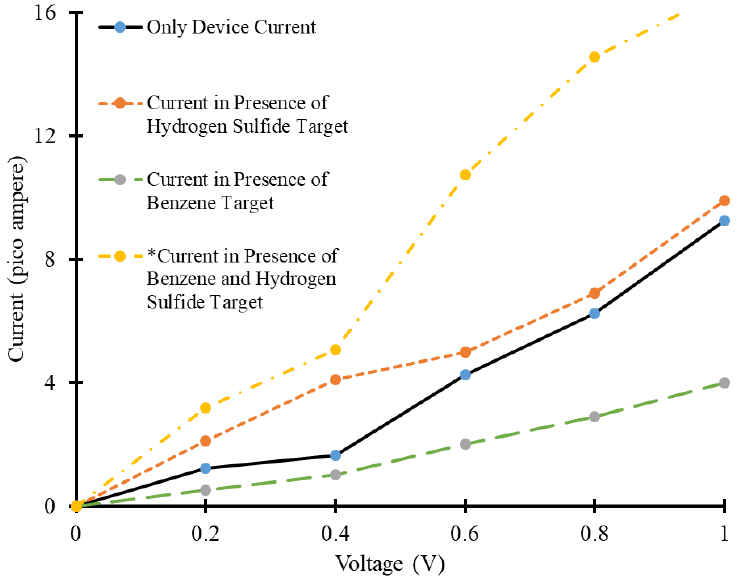
Figure 4. Current-voltage ( I - V ) curves of carbon nanotube based simulated device in the proximity of benzene and hydrogen-sulfide as target molecules (*multiply current axis with 10 6 to get the exact value of current in pico ampere for benzene and hydrogen-sulfide target curve).